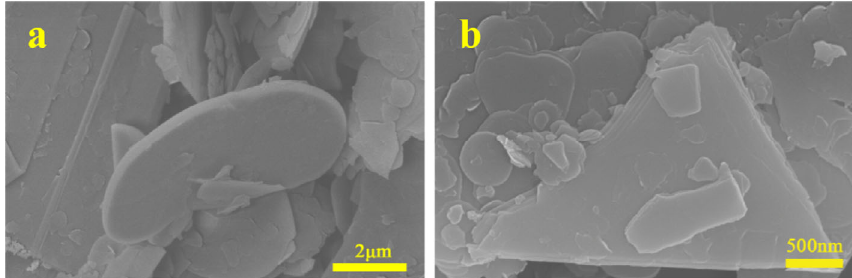
Fig. 2 SEM images of (a) the pristine h-BN powders and (b) the sediment of SH-BN after